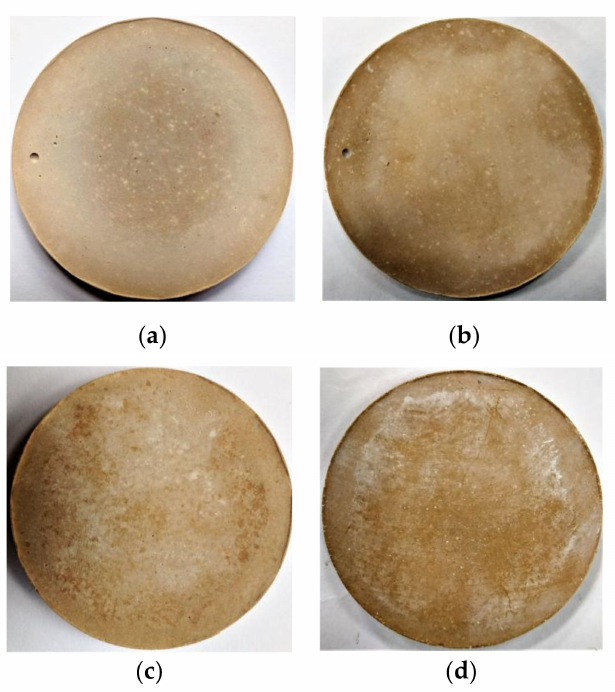
Figure 12. E ff ect of LBM content on the soundness of MPC: ( a , b ) LBM / M = 4%, ( a ) before boiling and ( b ) after boiling; ( c , d ) LBM / M = 8%, ( c ) before boiling and ( d ) after boiling.